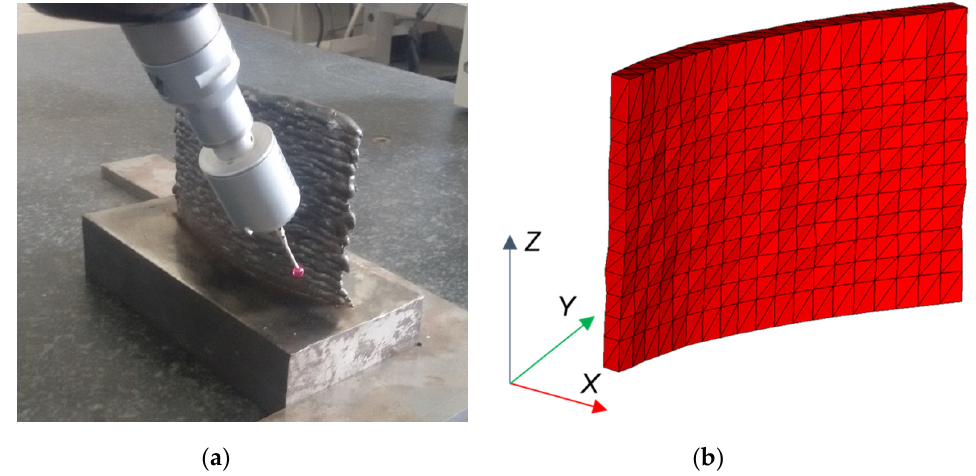
Figure 3. Coordinates-measurement-machine (CMM) measurement of the deposed airfoil ( a ), measured airfoil geometry ( b ).